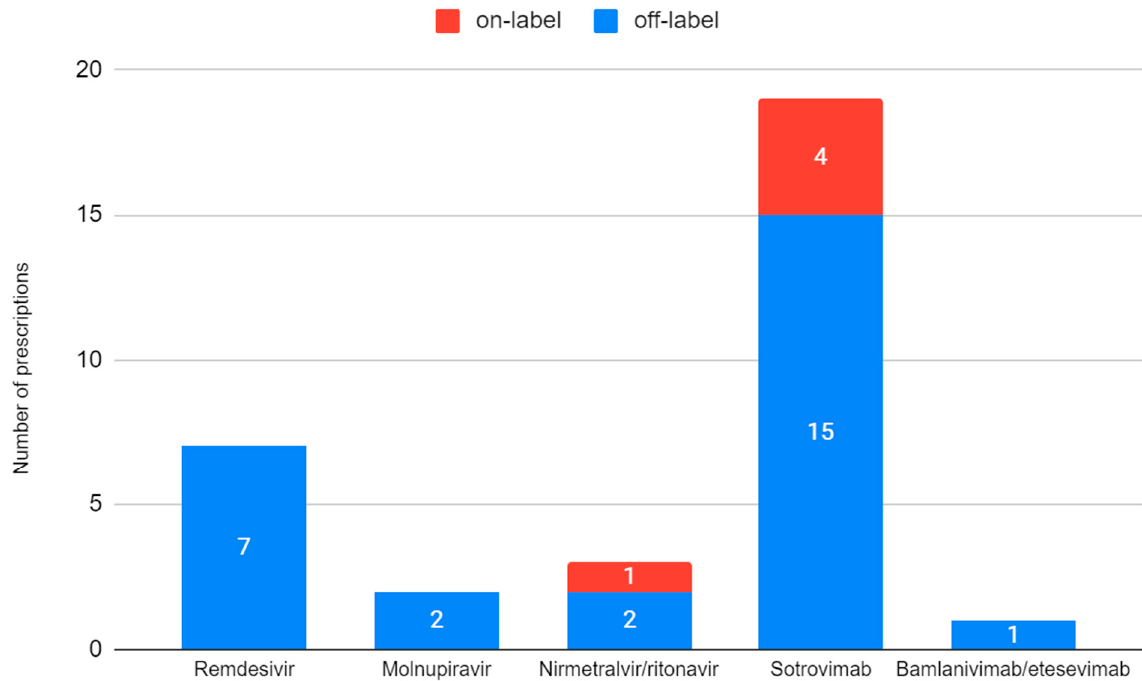
Figure 1. Off-label prescriptions according to the administered drugs.